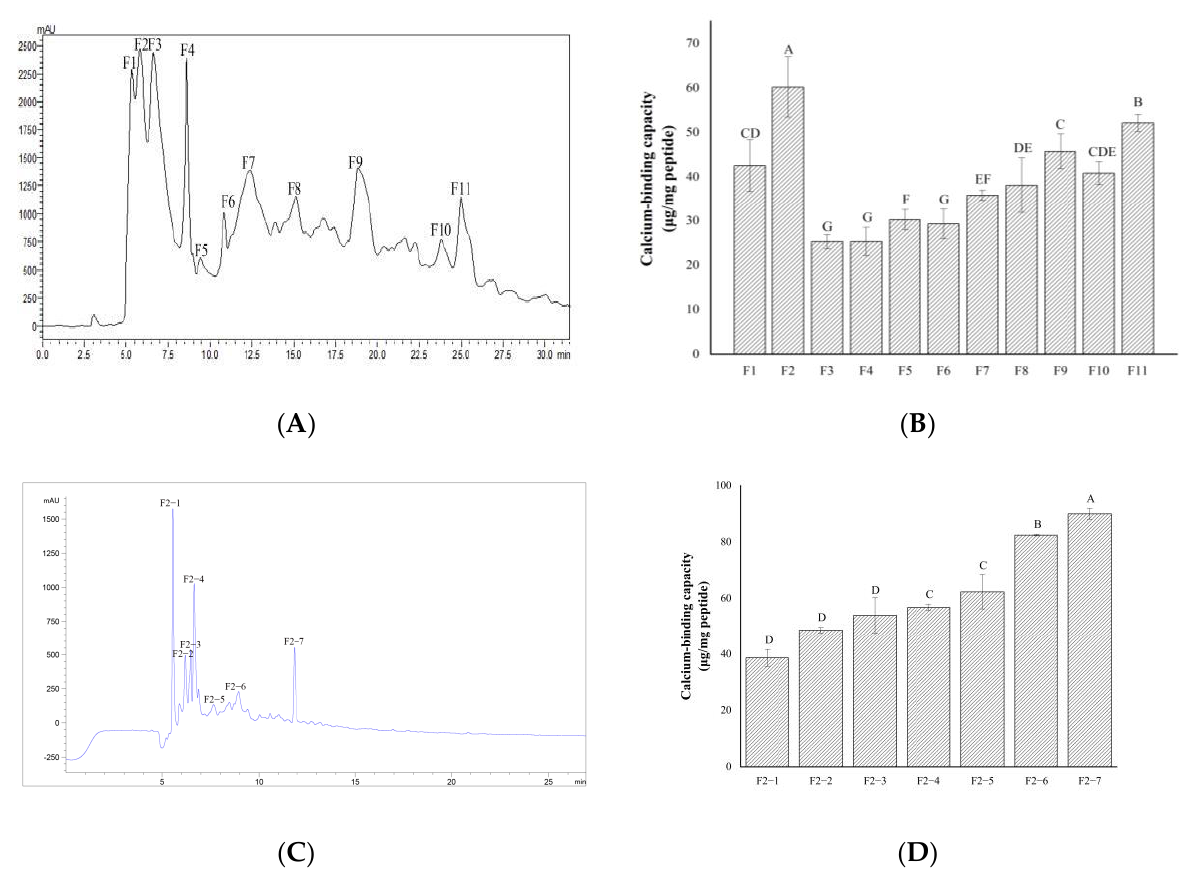
Figure 2. Elution curves of tilapia bone hydrolysates and calcium binding capacity of each fraction. ( A ) Shimadzu C−18 separated components. ( B ) Calcium binding capacity of Shimadzu C−18 separated components. ( C ) ZORBAX SB−C18 separated components. ( D ) Calcium binding capacity of ZORBAX SB−C18 separated components.